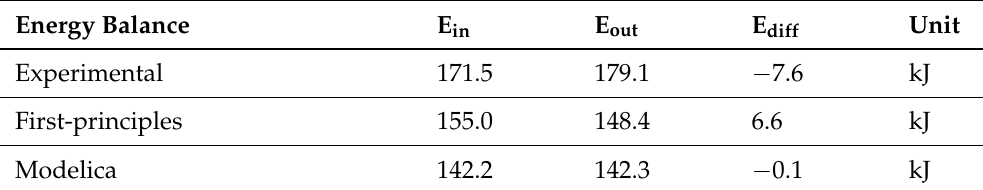
Table 9. Water-Side Energy Balance of Full Cycle.